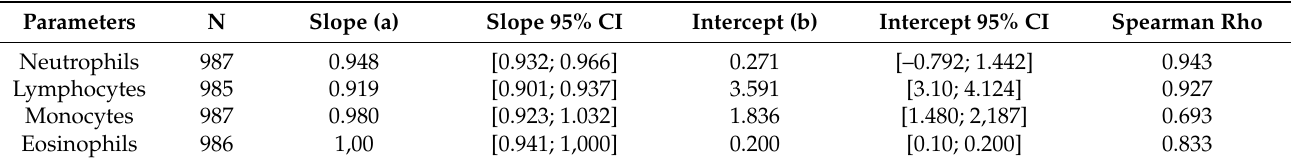
Table 5. Comparison of the XN20 for the leukocyte differential to the reference method (optic microscopy); slope and intercept results for the degree of association for each parameter analyzed Sysmex XN20 = a × Manual Diff + b. Parameters